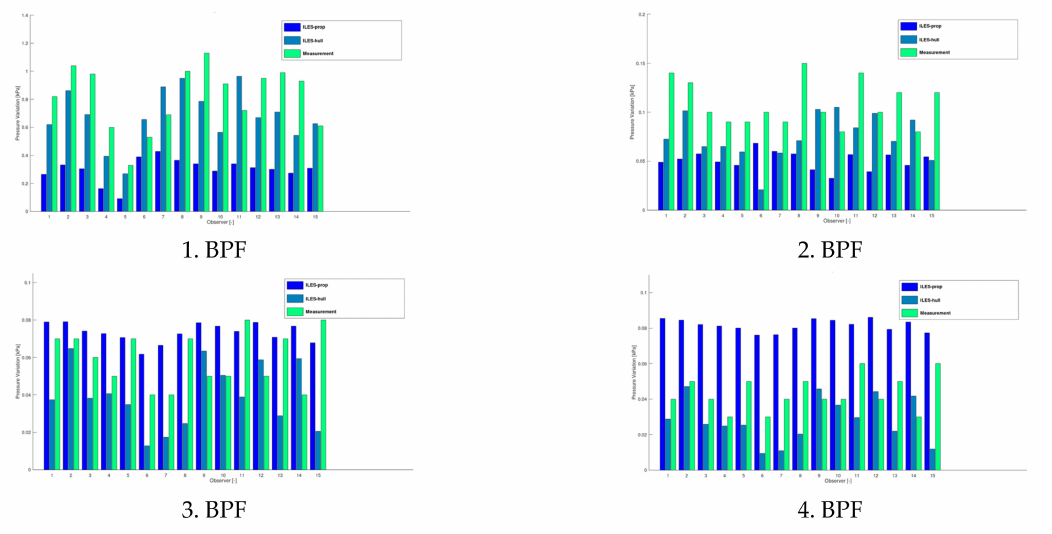
Figure 12. ProNoVi Target Case. Pressure amplitudes at multiples of the blade passing frequency (BPF) in comparison to the experiment with the model propeller only and the model propeller and ship hull in the propulsion condition with the results scaled to full